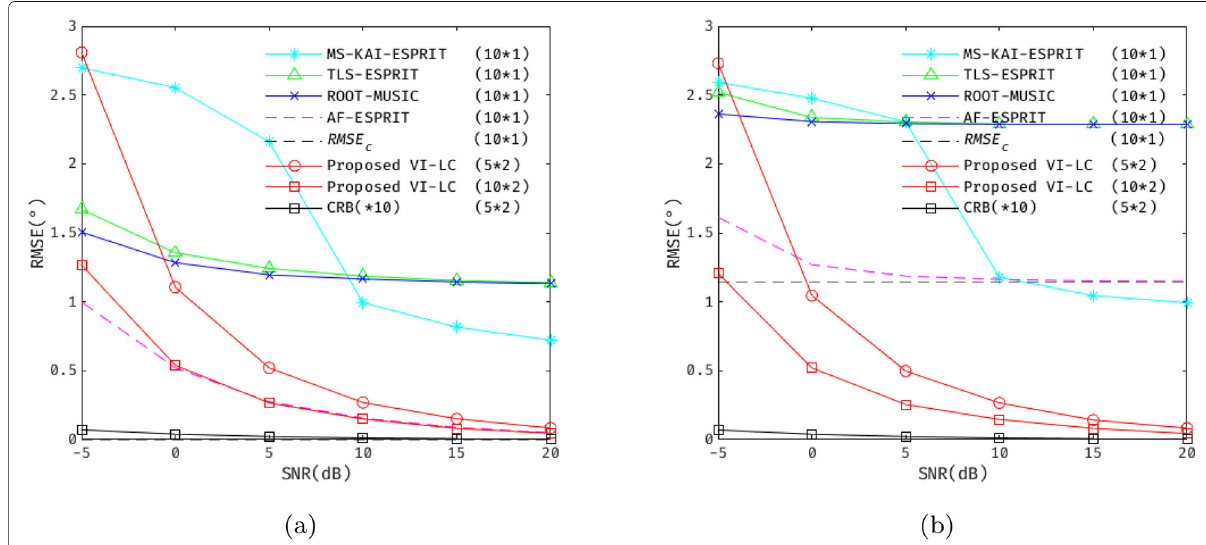
Fig. 6 RMSE versus SNRs. a (cid:8) c = 0 m/s and b (cid:8) c = − 25 m/s